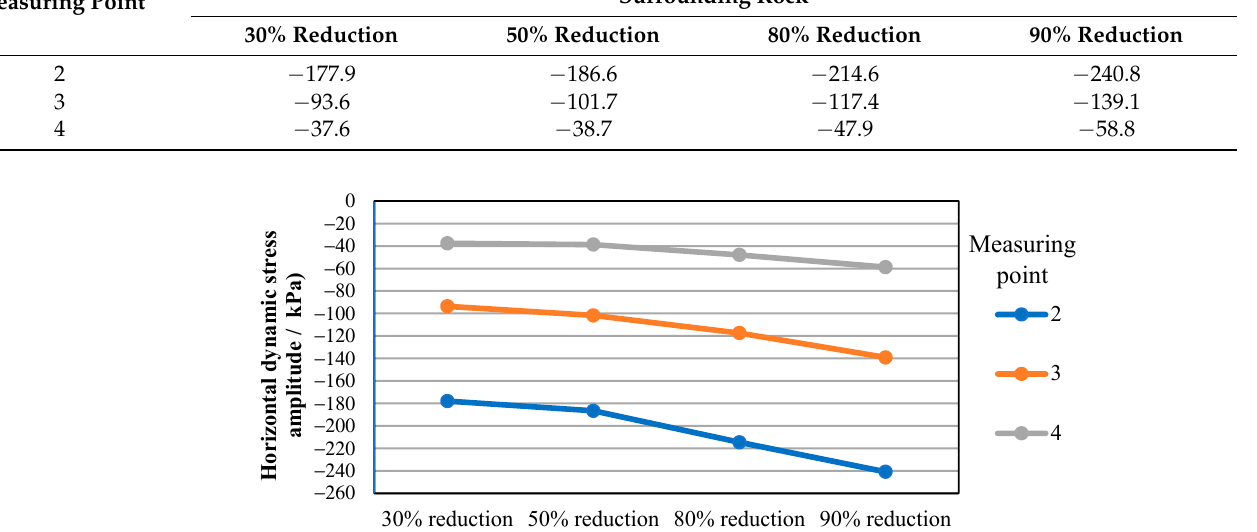
Figure 9. Horizontal dynamic stress amplitudes of measuring points 2, 3, and 4 under different softening degrees of the basement surrounding rock.